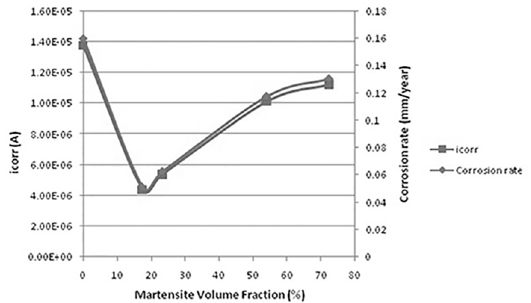
Figure 10. The variation of martensite volume fraction as a function of icorr and corrosion rate of DP